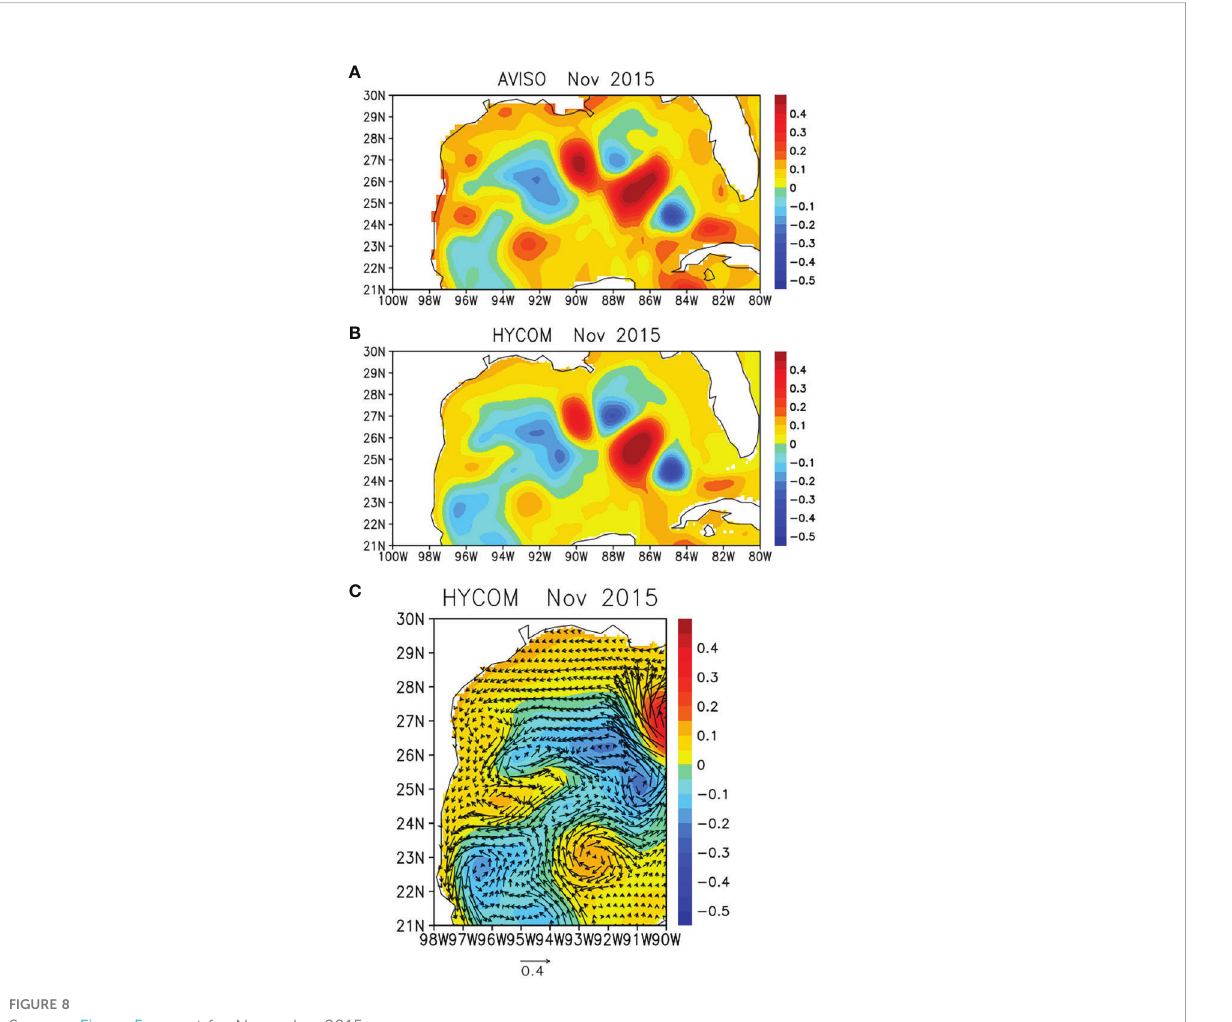
FIGURE 8 Same as Figure 5 except for November